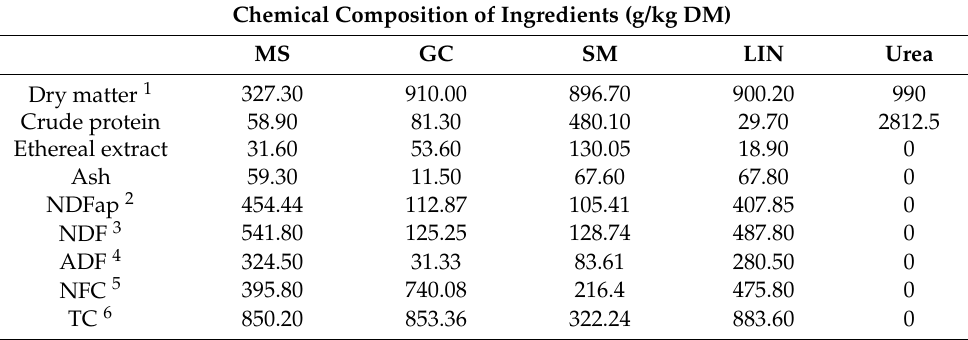
Table 1. Chemical composition of experimental diets ingredients, maize silage (MS), ground corn (GC), soybean meal (SM), cottonseed lint (LIN), and urea.